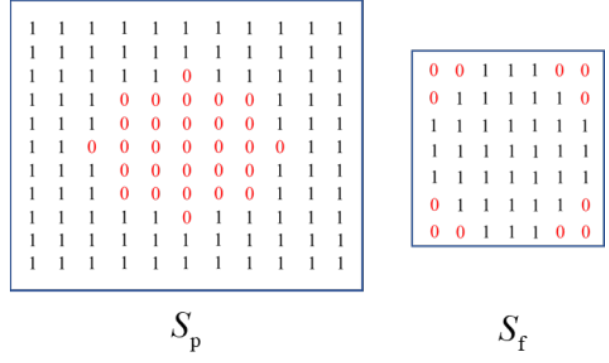
Figure 4. Relationship of the threefold structuring elements in our improved NWTH transfor- mation. 𝑆 consists of 𝑆 and 𝑆 , 𝑆 and 𝑆 represent structural elements for dilation and erosion 𝑝 𝑝 𝑓 𝑖 𝑜 operations, respectively.